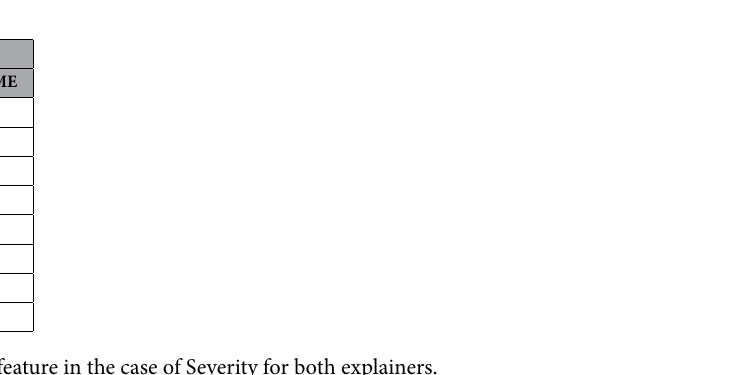
Figure 16. Explaining individual predictions of Gradient descent classifier by LIME.